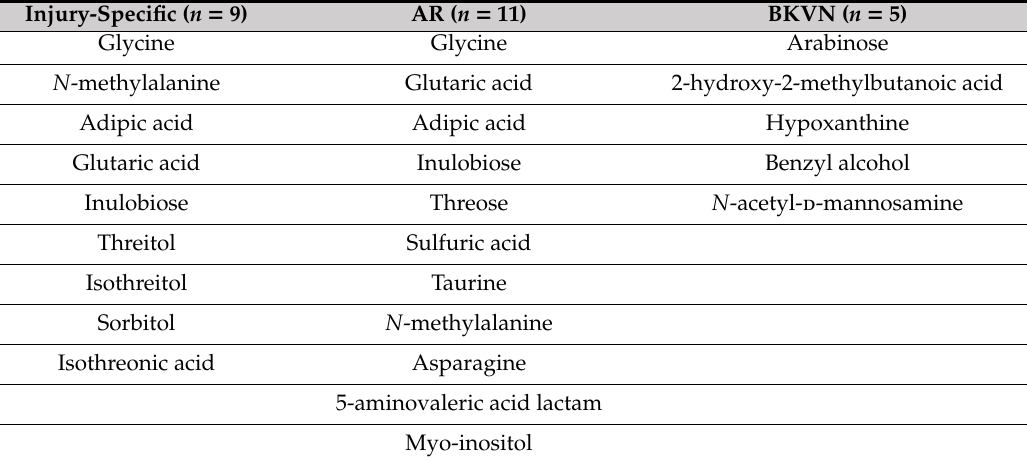
Table 2. Transplant phenotype-specific metabolite markers.